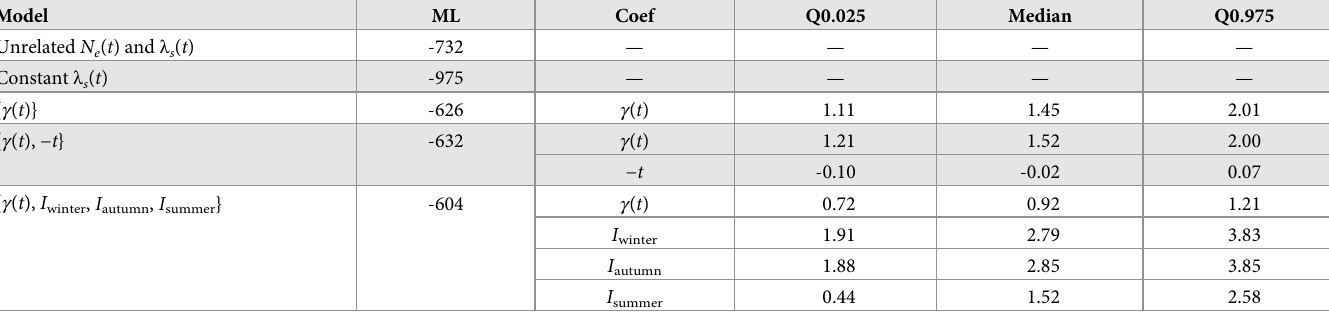
Table 3. Summary of USA/Canada influenza data inference. Posterior distribution quantile summaries for BEAST implementation of BNPR-PS models: with no covari- ates (model: { γ ( t )}), with an ordinary covariate (model: { γ ( t ), − t }), and with seasonal indicator covariates (model: { γ ( t ), I winter , I autumn , I summer }). Using a fixed tree, we also include marginal likelihoods (MLs) for all of the above models, plus a model with N λ s ( t )) and a conditional model combined with a constant sampling intensity model for sampling times (Constant λ s ( t